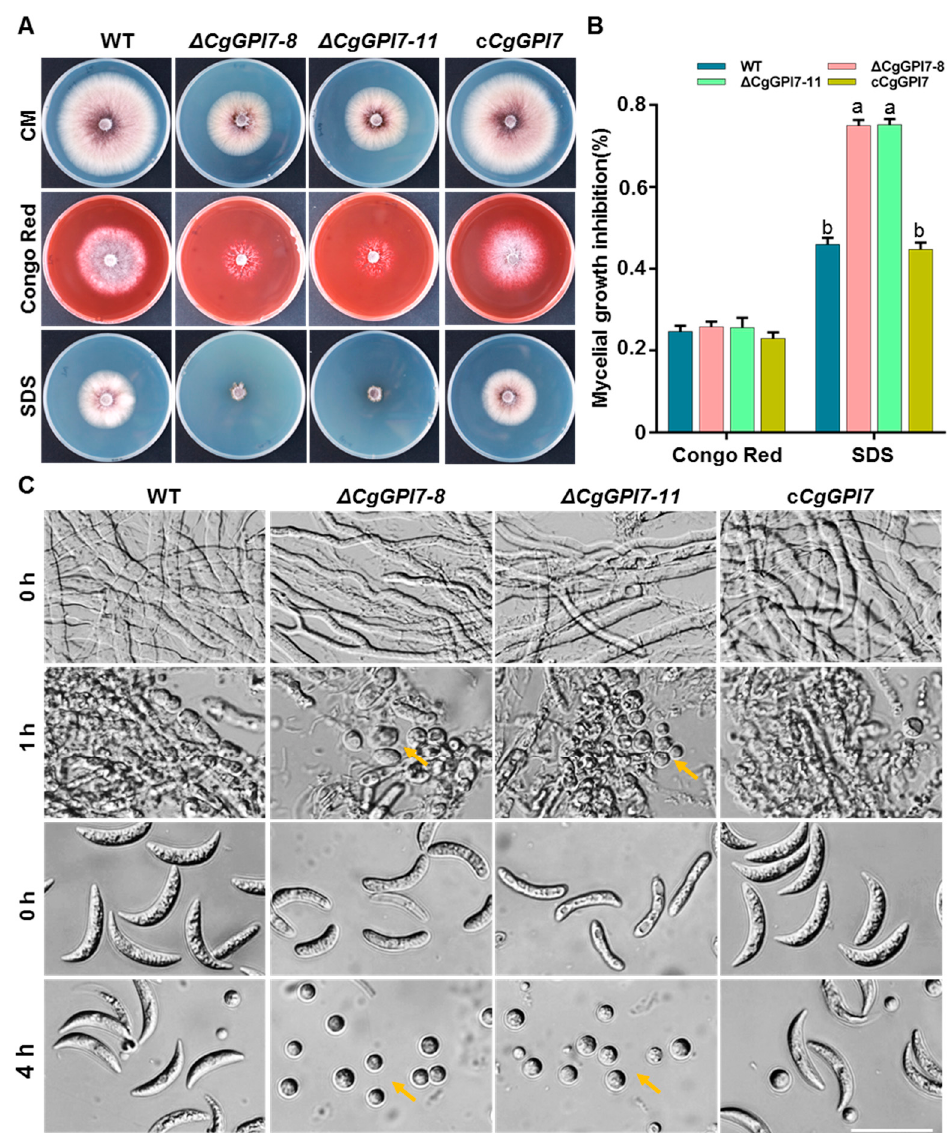
Figure 6. CgGPI7 is involved in cell wall integrity. ( A ) Colony morphology of wild types, Δ CgGPI7-8 , Δ CgGPI7-11 , and c CgGPI7 were identified by growing these strains on a CM medium that was amended with 0.8 mg/mL ( w/v ) Congo Red and 0.0025% ( w/v ) SDS. ( B ) Statistical analysis of the inhibition rate of mycelial growth. Bar indicates the standard deviation of three replicates and the small letters indicate a significant difference ( p < 0.01). ( C ) The mycelial and conidia of indicated strains were treated with cell wall-lysing enzymes for 1 h and 4 h, respectively. Bar = 25 μ m. Orange arrows indicate the released protoplasts.